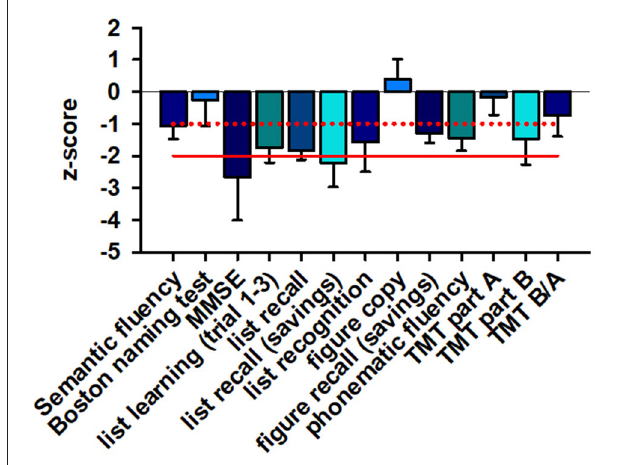
FIGURE 1 | Neuropsychological data. MMSE sum scores and verbal memory recall are severely affected in patients, whereas verbal and figural memory, phonematic fluency, cognitive flexibility (TMTB) are only mildly affected. The z-score of different cognitive subdomains is depicted. The red line indicates the − 2 z-score value whereas the dotted red line shows the − 1 z-score value. A ≤ − 2 z-score value is regarded as major cognitive dysfunction whereas a ≤ − 1 value is as considered minor cognitive dysfunction. MMSE, mini mental status examination; TMT, trial making test.